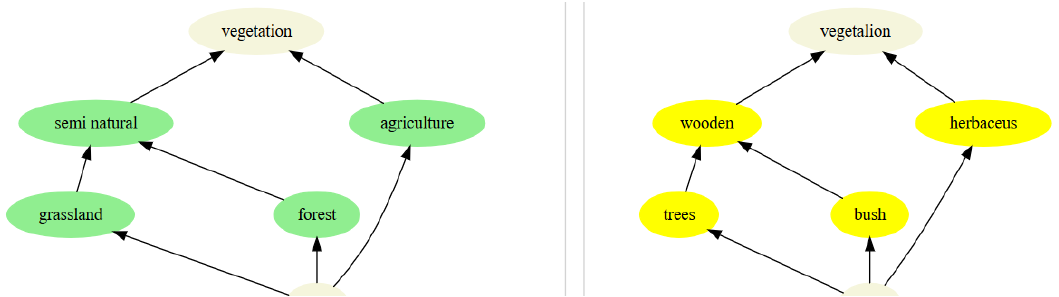
Figure 5. Two ontologies computed as the Galois lattices derived from two observation sets.